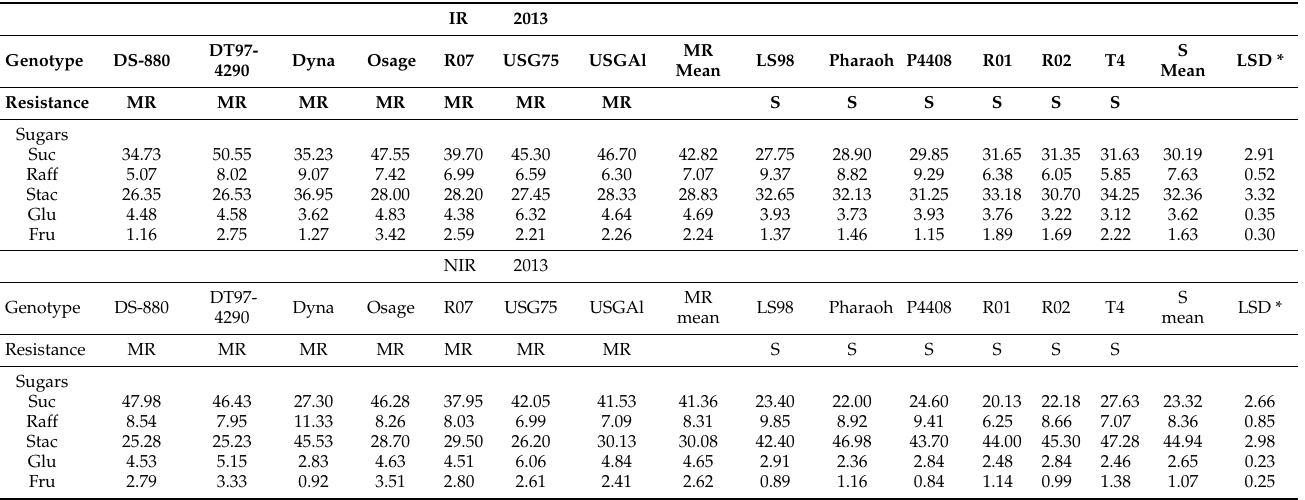
Table 5. Levels (mg/g) of seed sucrose (Suc), raffinose (Raff), stachyose (Stac), glucose (Glu), and fructose (Fru) in moderately resistant (MR) and susceptible (S) soybean genotypes to charcoal rot infection under irrigated (IR) and non-irrigated (NIR) conditions. The experiment was conducted in 2013 in Jackson, TN, USA.